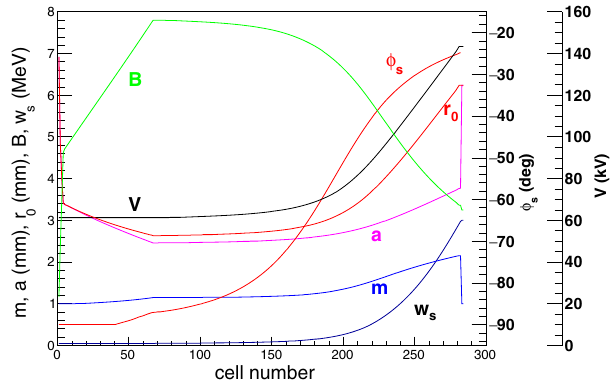
FIG. 1. Cell parameters of the fully equipartitioned RFQ. The W s means the energy of the synchronous particle. The the output transition cell [13] are not plotted.